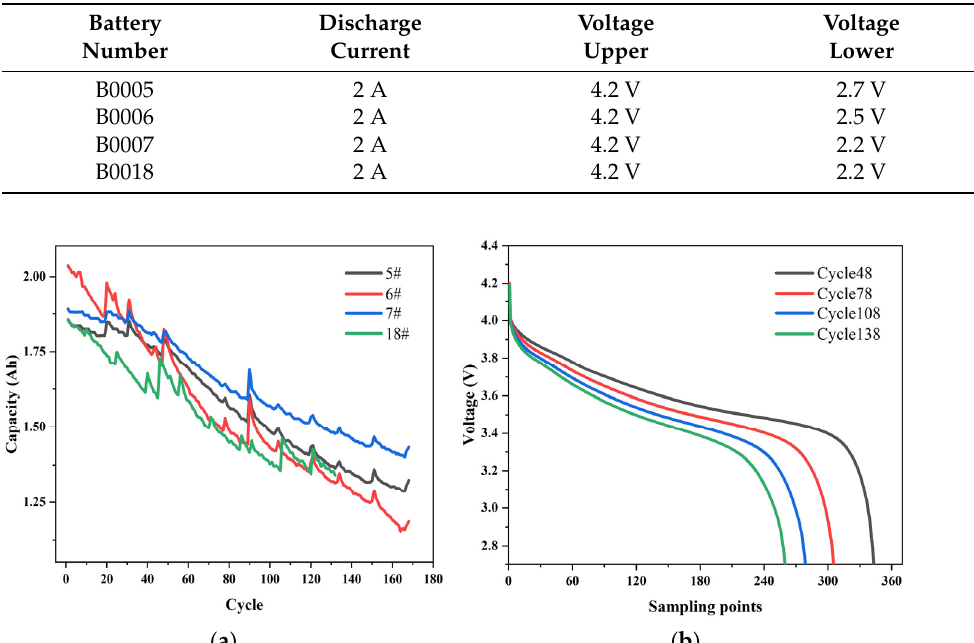
Table 1. Experiment condition of the battery.